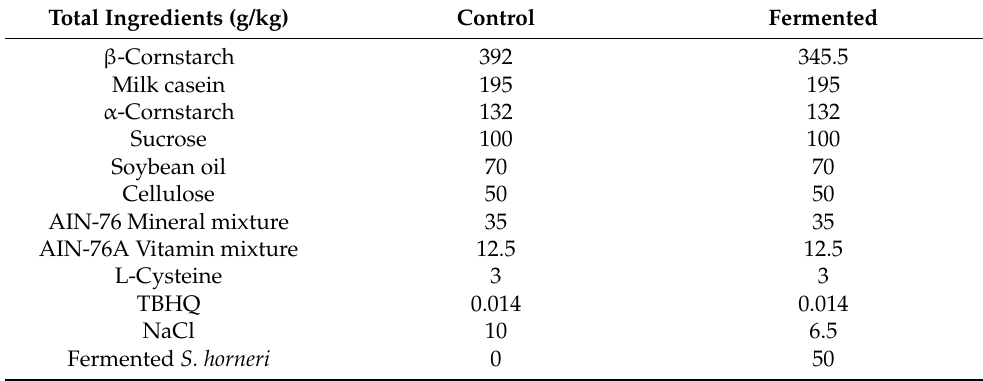
Table 1. Diet composition.